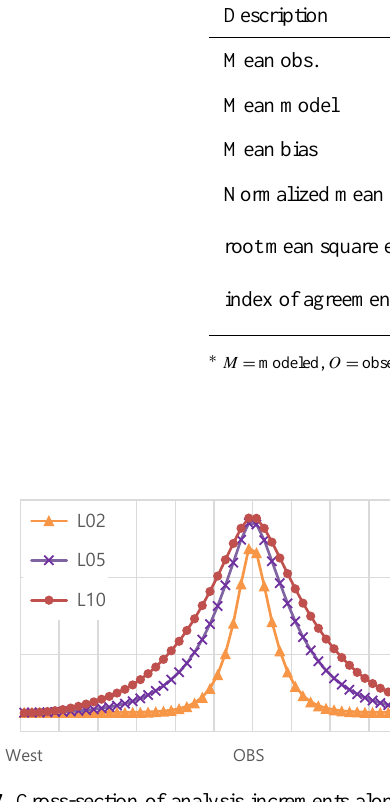
Figure 7. Cross-section of analysis increments along the blue line in Fig. 6b as the radius of influence ( L) values are